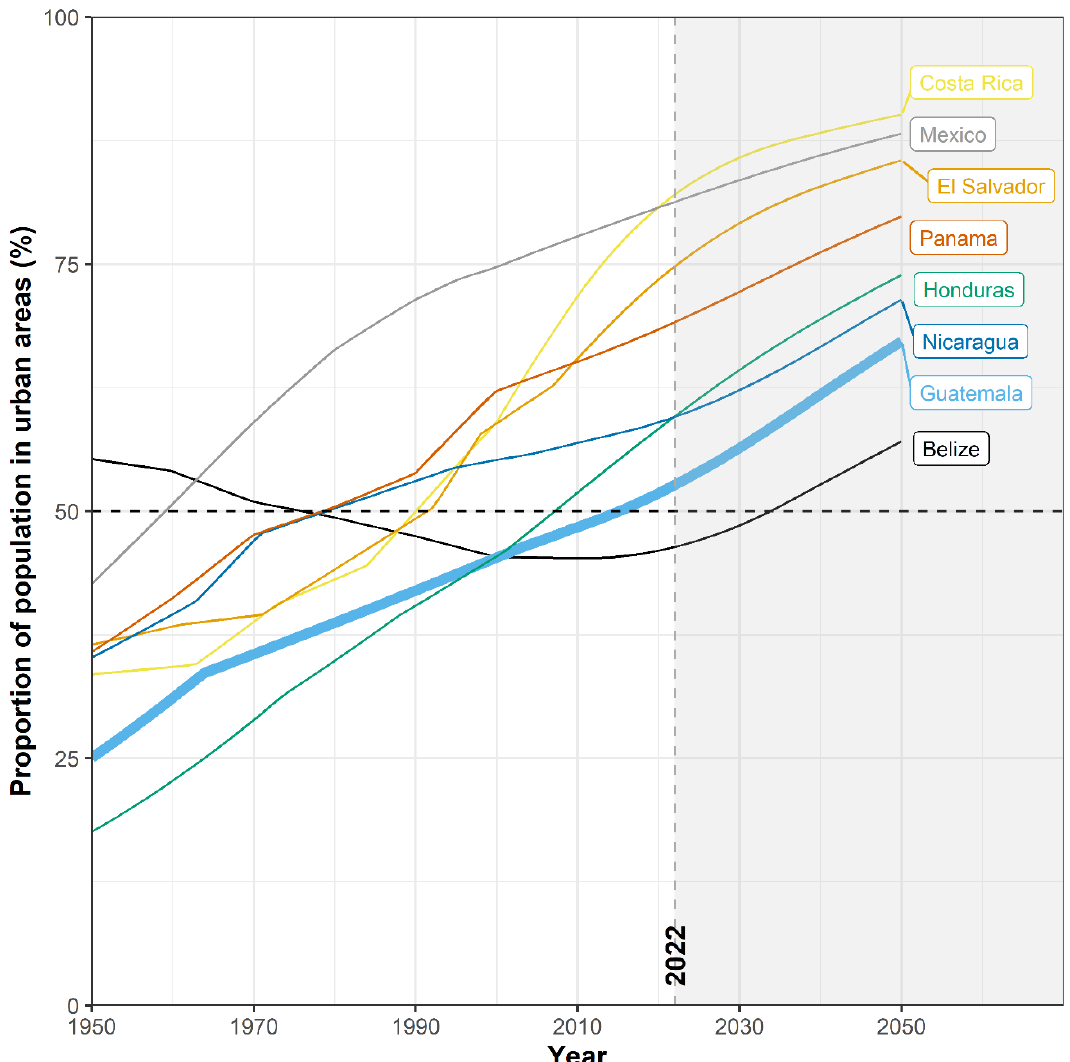
Figure 1. Rates of urbanization in Central American countries 1950 to present, with projected rural/urban proportions shown through 2050. Thick line emphasizes Guatemala trend. Data from World Urbanization Prospects, by the United Nations (UN), Department of Economic and Social Affairs, Population Division, © 2018 UN. Data used with the permission of the UN [6] .